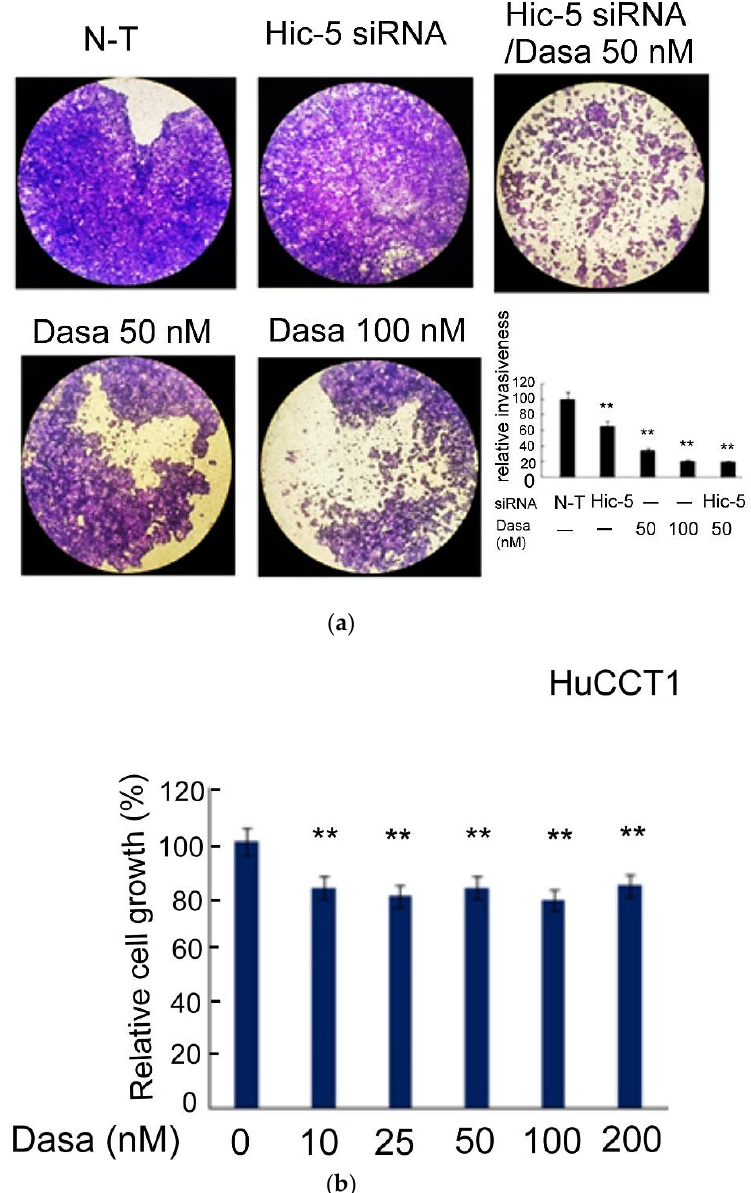
Figure 1. Src – Hic-5 signal cascade is required for HuCCT1 cell invasion. HuCCT1 cells were transfected with Hic-5 siRNA, treated with dasatinib (Dasa) or a combined transfection with Hic-5 siRNA coupled with treatment of Dasa at indicated concentrations for 48 h ( a ); HuCCT1 cells were treated with Dasa at indicated concentrations for 48 h ( b ). Transwell Matrigel invasion assay ( a ) and MTT assay ( b ) were performed. In ( a ), the images shown are the crystal-violet-stained invaded cell, pictured under a 40× magnification. Quantitation of the staining intensity using imageJ software is shown in lower right panel. Relative invasiveness was calculated taking the data of nontargeting (N-T) group as 100%. In ( b ), relative cell growth was calculated based on the absorbance measured under 535 nm, taking the data of Dasa at 0 nM as 100%. (**) represents the statistical significance ( p < 0.005, N = 6) of the differences between the indicated sample and the N-T ( a ) and Dasa at 0 nM ( b ) groups, respectively.